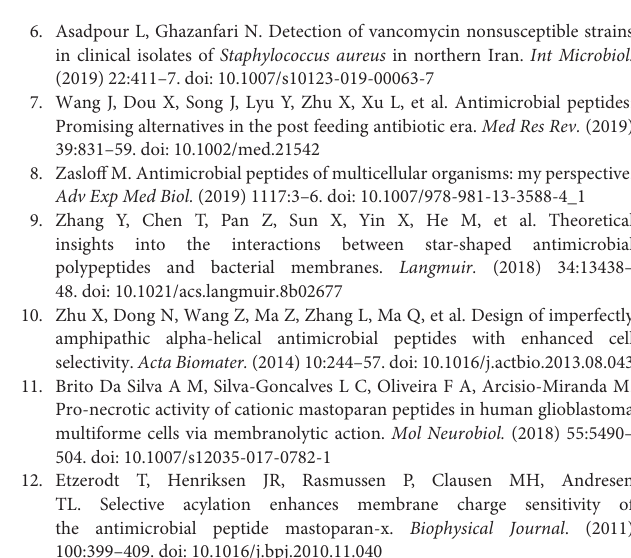
Supplementary Figure 1 | Proteinase K treatment on the antibacterial activity of MPX. Error bars indicate the mean ± SEM, n = 3. Statistical significance was defined as ∗∗∗∗ P < 0.0001. Supplementary Figure 2 | Trypsin treatment on antibacterial activity of MPX. Error bars indicate the mean ± SEM, n = 3. Statistical significance was defined as ∗∗∗∗ P < 0.0001; ns P >